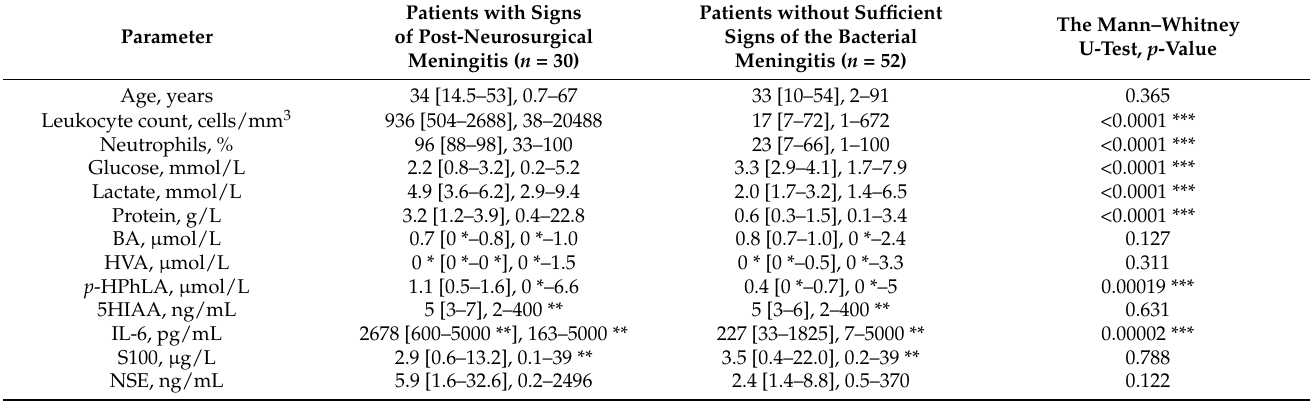
Table 2. The results of the laboratory tests and the concentrations of aromatic metabolites and biomarkers in the CSF samples of the post-neurosurgical patients ( n = 82), including the results of the Mann–Whitney U-test. Data are presented as median [interquartile range 25–75%], minimum– maximum